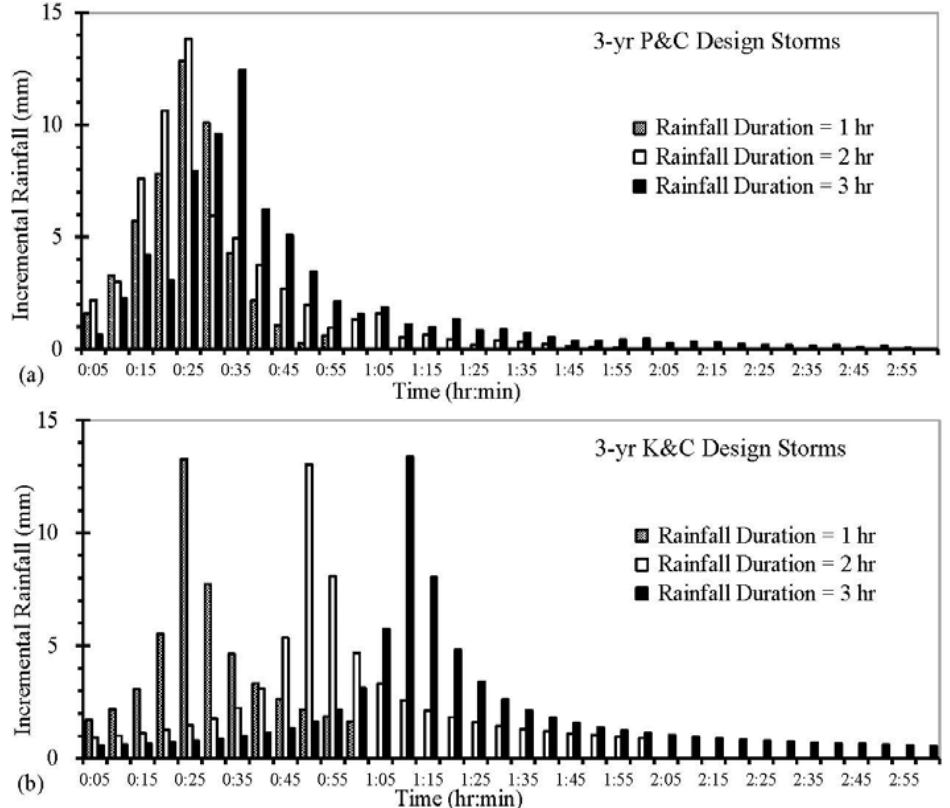
Figure 5. Three ‐ year Beijing design rainfall distributions using the P&C method ( a ) and the K&C Figure 5. Three-year Beijing design rainfall distributions using the P&C method ( a ) and method ( b ) for three rainfall durations. the K&C method ( b ) for three rainfall